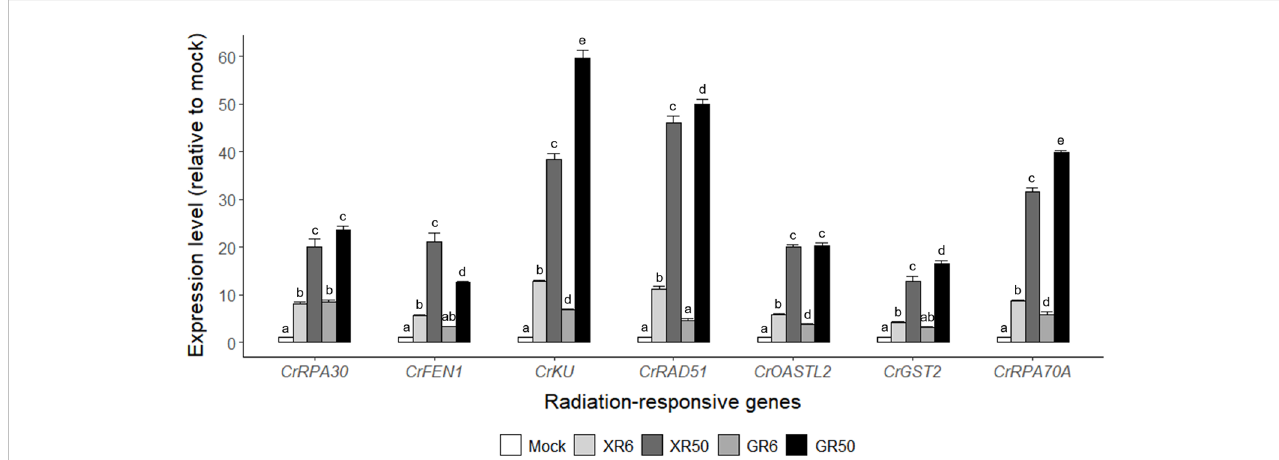
FIGURE 3 Relative transcription levels of the seven DNA damage response (DDR) genes from RNA-Seq analysis of X- or g -irradiated C. reinhardtii cells. XR6 (GR6) and XR50 (GR50) represent X-rays ( g -rays) of 6 and 50 Gy, respectively. All transcription levels were measured by quantitative real-time polymerase reaction (RT-qPCR) and are shown relative to the mock by using CrTUBA1 as an endogenous reference gene. Data represent the mean ± standard error (SE) with n = 9 from three independent experiments. Different letters indicate signi fi cant differences at p < 0.05 (one-way analysis of variance followed by Tukey ’ s honestly signi fi cant difference